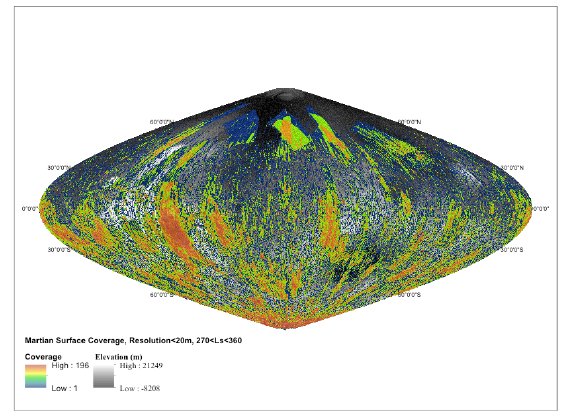
Figure 2: Martian surface coverage during north hemisphere winter ( 270 o <Ls<360 o ) from 1977-2013. The above Figures are examples from only 2 of the 24 maps (namely, maps F2 and F4) that will be presented during the ISPRS TCIV symposium and are omitted here due to lack of space. From these 24 maps, 16 correspond to the previously discussed sub-classes, i.e. they would be a plot of the number of times each Martian region was imaged at the sub-class context. For example, a pixel with a value 12 in an F2 map would correspond to an area that was mapped 12 times during NH summer with resolution finer than 20 metres per pixel. The map raster grid is 500mx500m using a sinusoidal